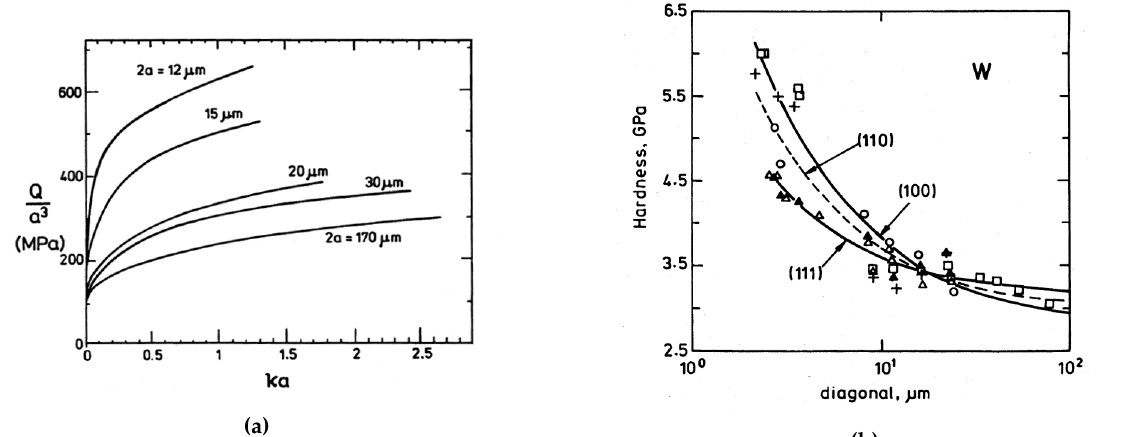
Figure 3. Variation of Torsional stiffness during torsion test on a copper wire ( a ) and variation of Hardness during microindentation test on tungsten single crystal ( b )